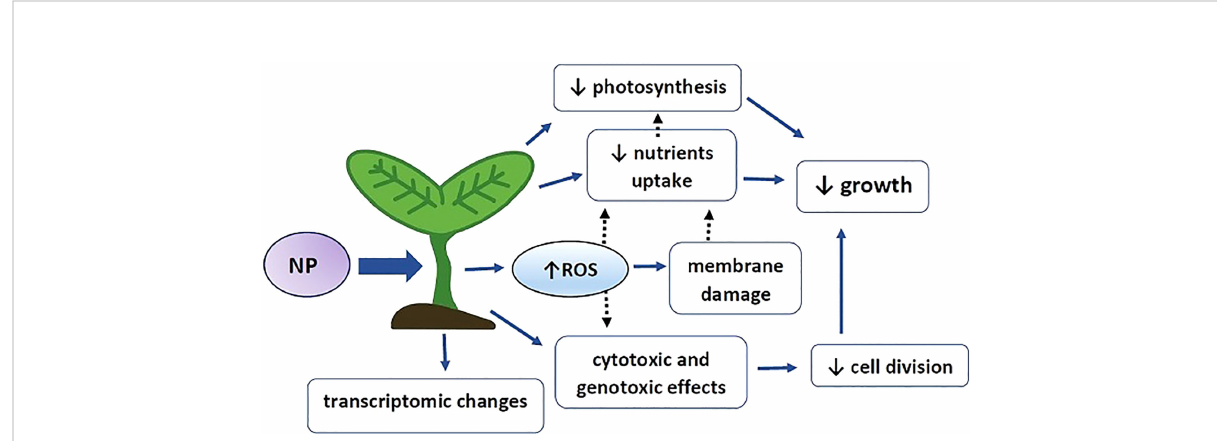
FIGURE 5 Graphical summary of NP impact on plants. NP – nanoplastic particles, ROS – reactive oxygen species, blue arrows – experimentally evidenced effects, black dotted arrow – possible interactions. Exposure to NP leads to increase in reactive oxygen species, hampered uptake of speci fi c nutrients, decrease in photosynthesis ef fi ciency and cyto- and genotoxic effects. ROS might mediate cyto- and genotoxic effect through direct interaction with genetic material and alert nutrient uptake through mediation of membrane damage. Decrease in the level of certain elements e.g. Fe and Mg might results in impaired chlorophyll synthesis and contribute to lower photosynthesis ef fi ciency. Cyto- and genotoxic effects lead to decreased cell division. Alerted cell division, nutrient level and photosynthesis results in hampered plants growth. In addition, NP alert plants physiology through modulation of genes expression on the transcriptomic